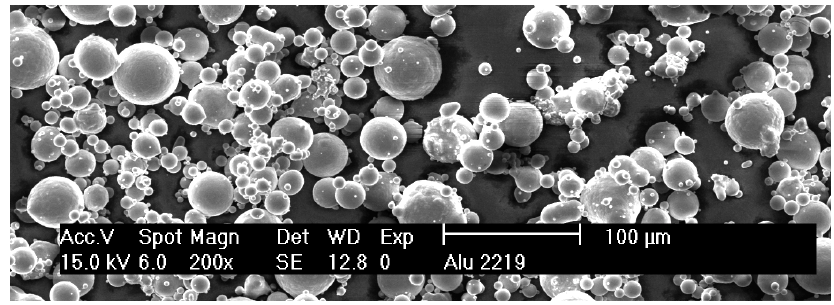
Figure 2. Scanning electron microscope (SEM) image of argon atomized and sieved EN AW-2219 powder.